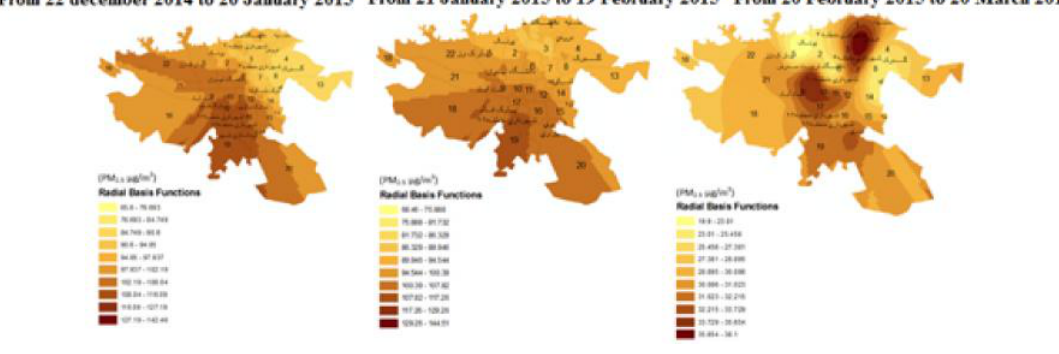
three months of winter season in Tehran